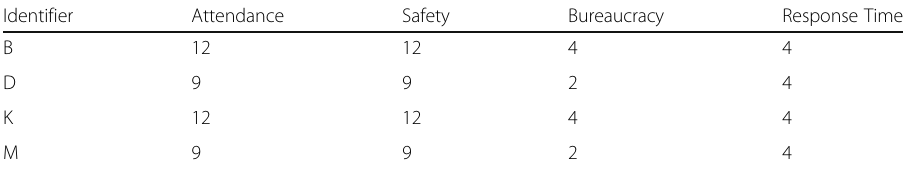
Table 7 Selected